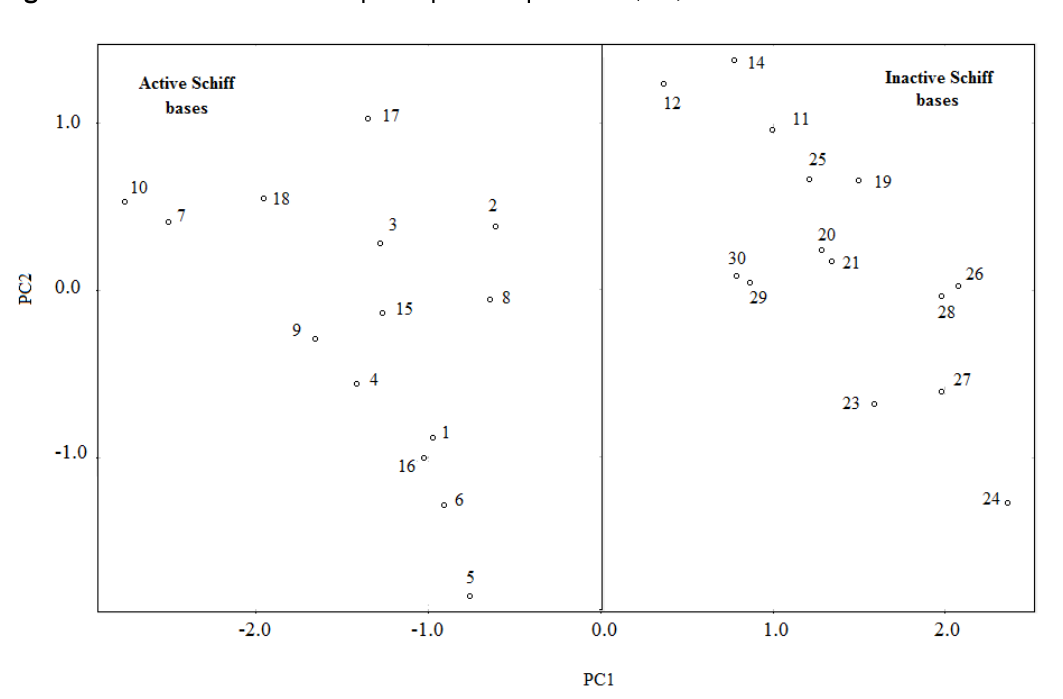
Figure 2. Plot of the first two principal components (PC) score vectors for Schiff